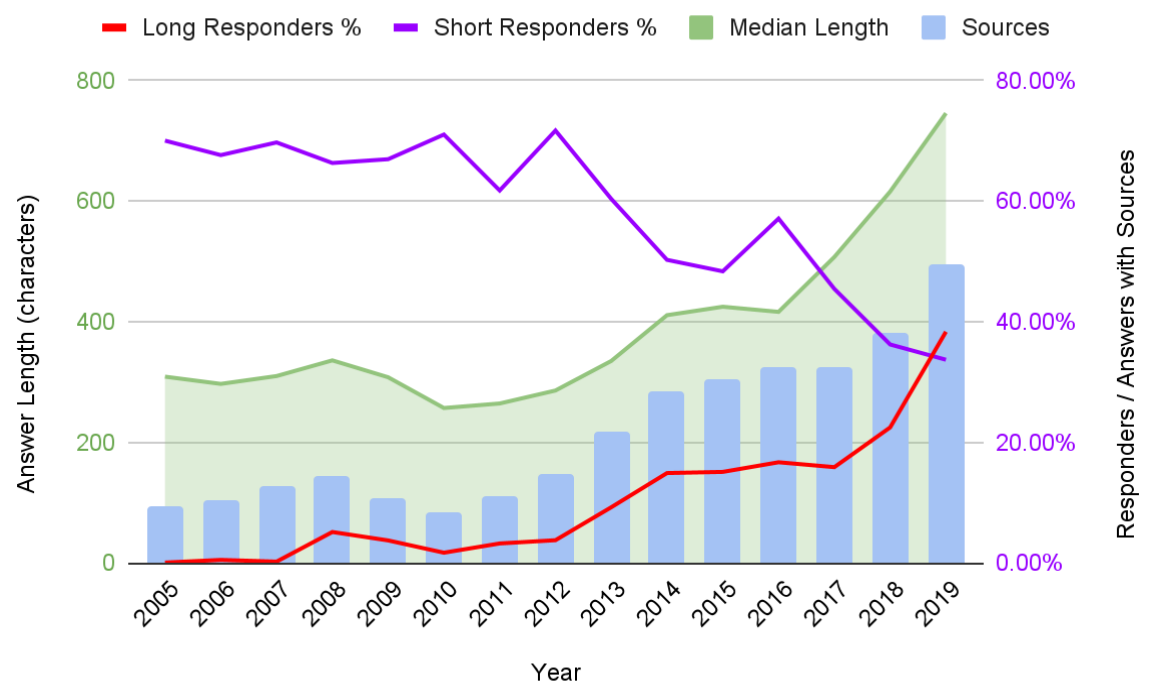
Figure 3. Comparison of length of responses and sourcing count with volume of rabbis who wrote long replies. The purple line represents the rabbis who are in the lower quartile in terms of the average length of their answers on the site (short responders). The red line depicts the rabbis who are in the top quartile of the average length (long responders). The green line shows the median length of the responses based on their character count. Finally, the blue bars show the percentage of responses that contain sources.